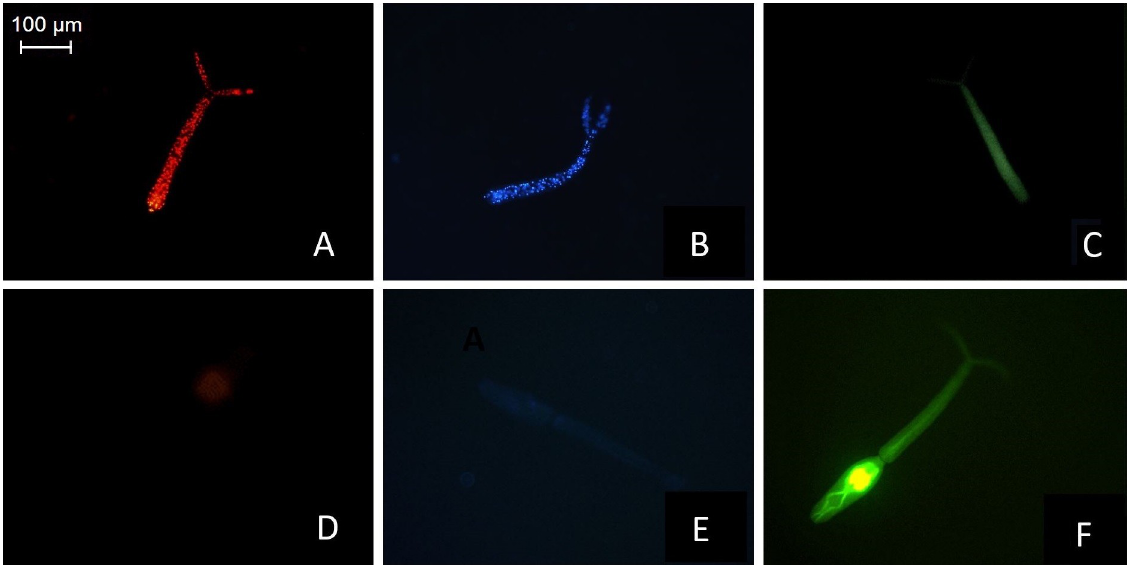
Fig 1. Individually PI (A and D), Hoechst (B and E) and FDA (C and F) stained cercariae. The PI and Hoechst-stained dead cercarial tails (A and B) show the staining of the nucleic acid. Both tails fluoresce strongest at the tail-head junction, as this is where most ruptured cell membranes are found resulting from the tail separation. The FDA-stained whole live cercaria (F) fluoresces strongest in the acetabular glands. Image D, E show a live cercaria stained with PI and Hoechst, respectively. Image C shows an FDA-stained dead cercaria.